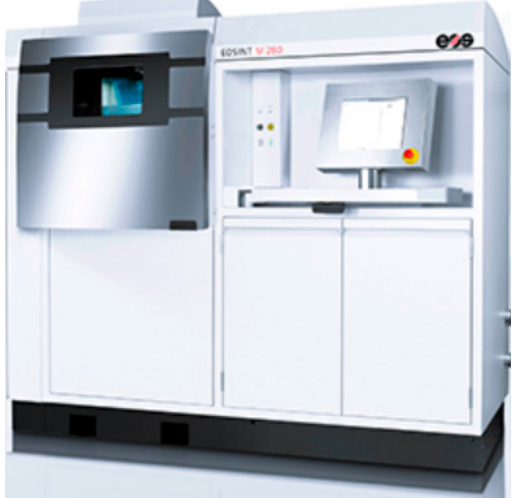
Figure 3. The EOSINT M 280 selective laser melting (SLM) system.